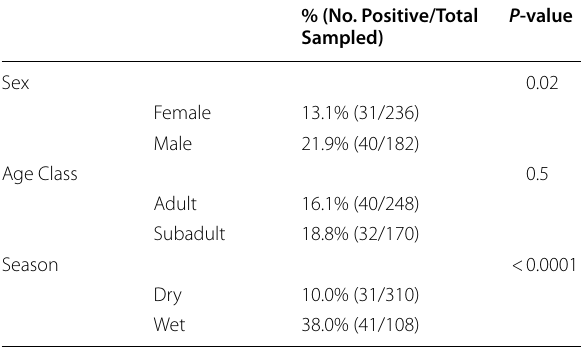
Table 2 Percentages of bats positive for coronavirus RNA by host demographics (sex and age class) and season (dry/ rainy). P ‑values correspond to Chi‑square tests evaluating the associations between coronavirus RNA positive bats and sex and age class of the bats as well as season